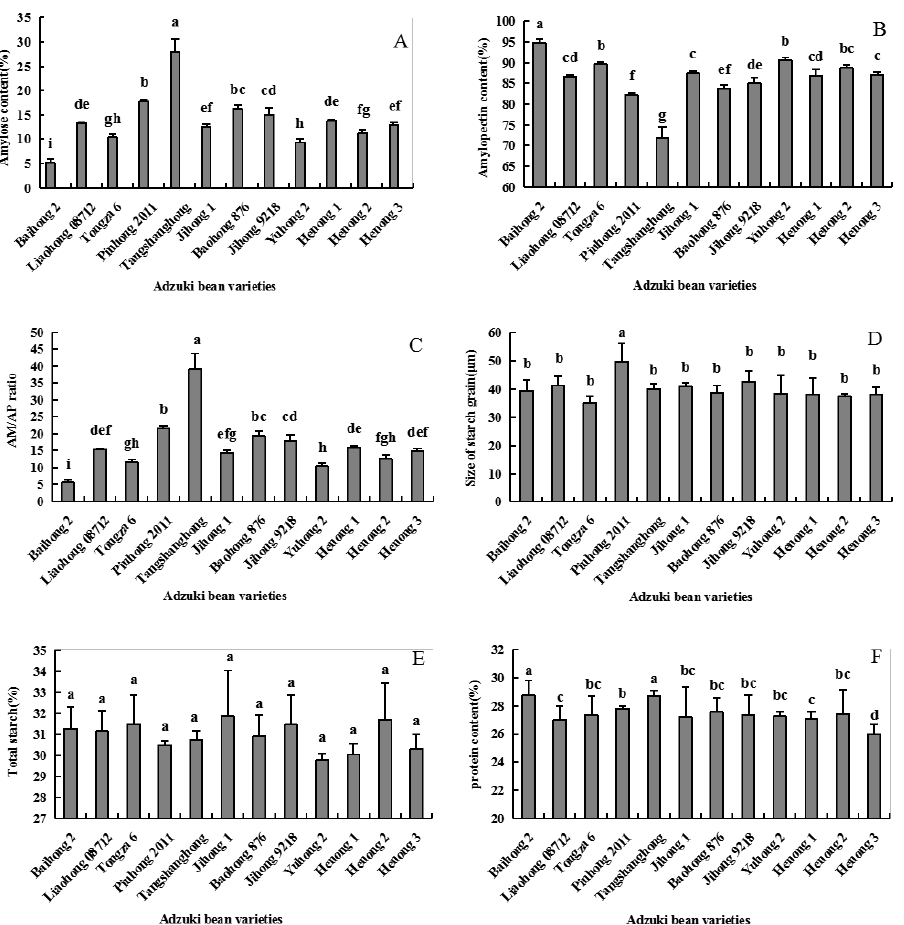
Figure 2. The AM ( A ) and AP ( B ) content, AM/AP ratio ( C ), starch size ( D ), total starch ( E ) and protein content ( F ) of different adzuki beans. Note: Different lowercase letters indicate significant difference of 0.05 level, LSD method.